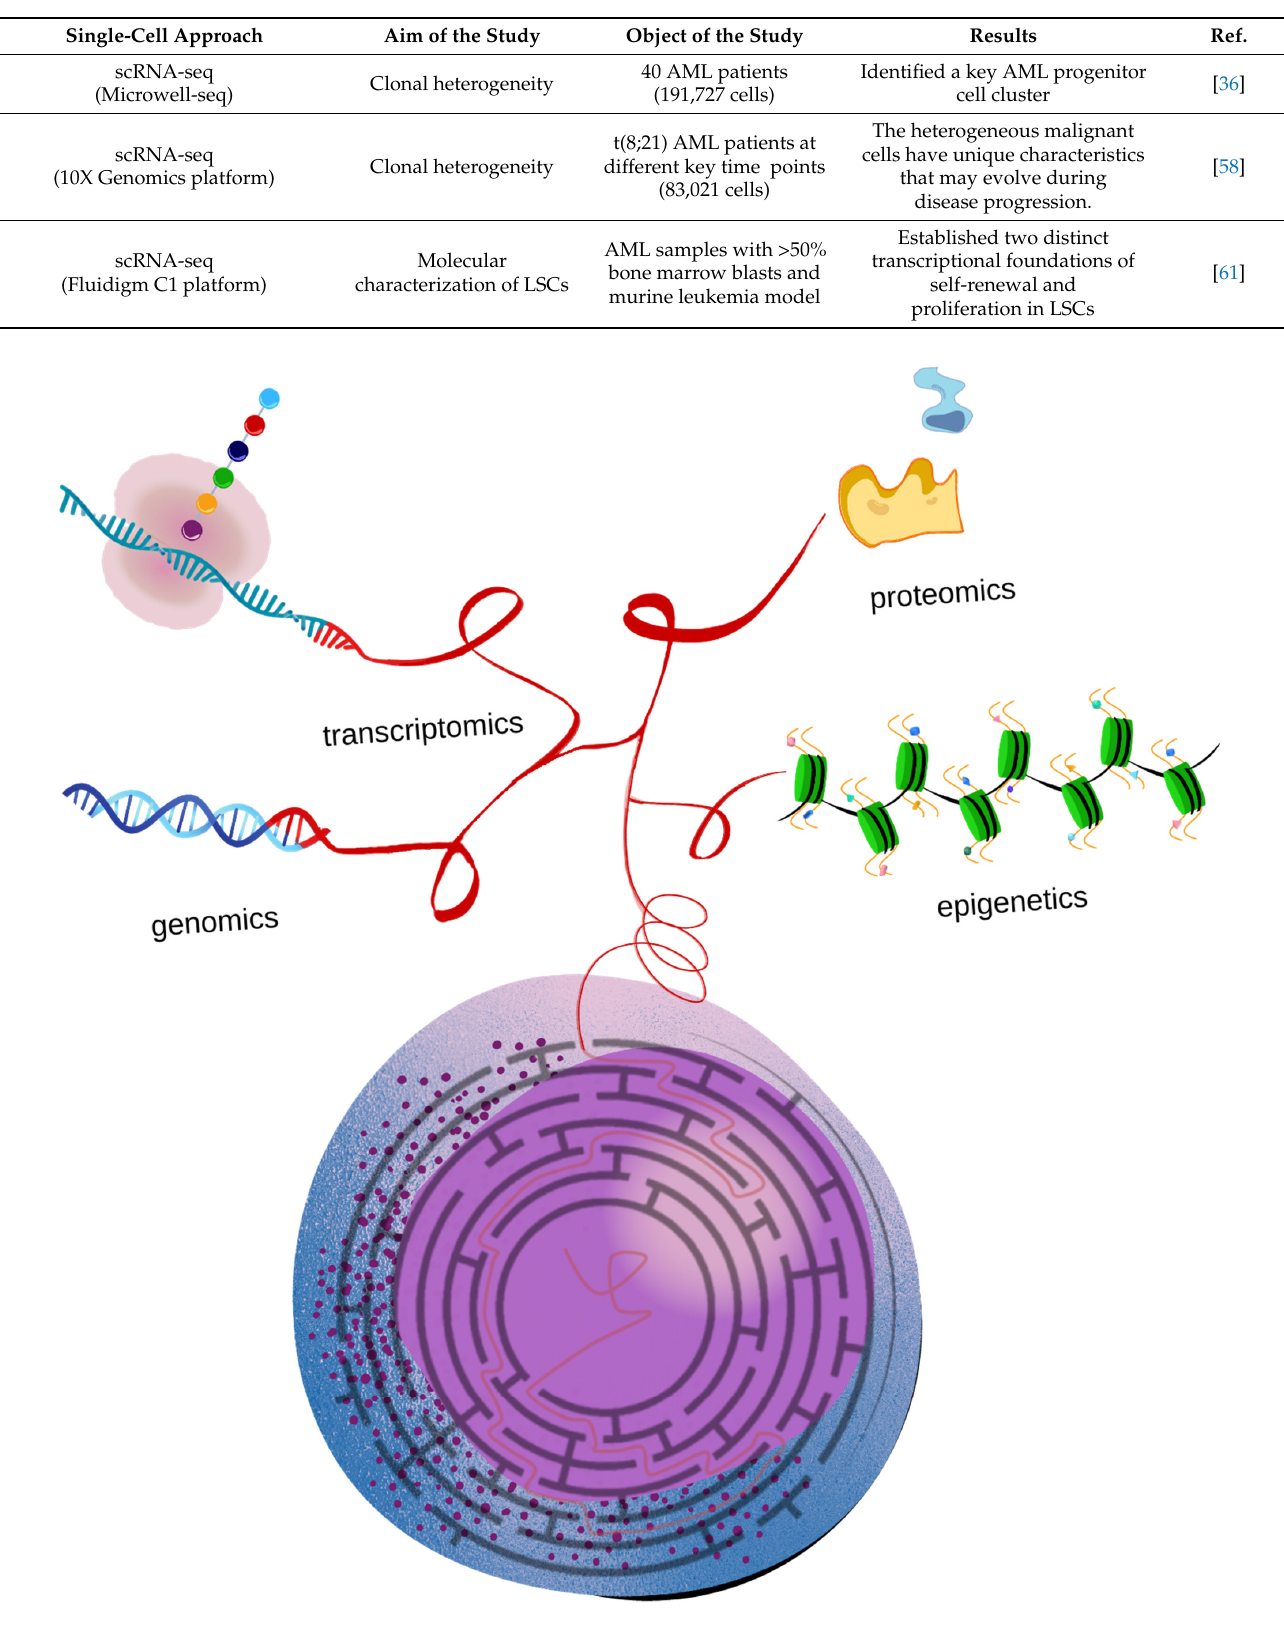
Figure 1. Single-cell studies of different biological levels allow for solving the complex AML maze.